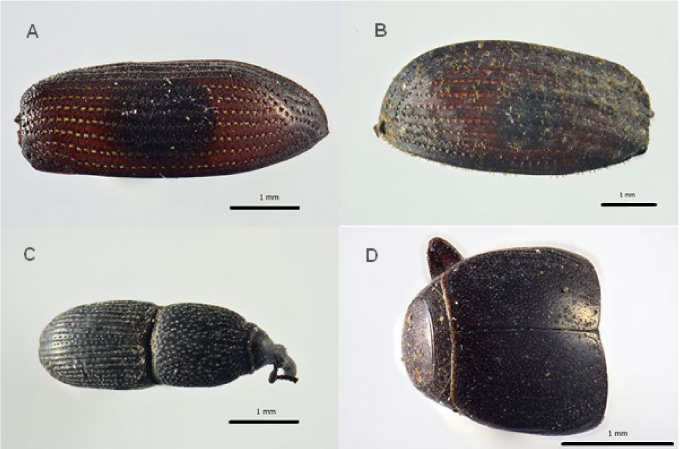
Figure 3. Coleoptera remains associated to the burial site of Saint Davino Armeno: ( A ) Anobium punc- tatum right elytra, ( B ) Trox scaber , left elytra, ( C ) Sitophilus granarius body, dorsal view, ( D ) Gnathoncus sp., abdomen dorsal view.